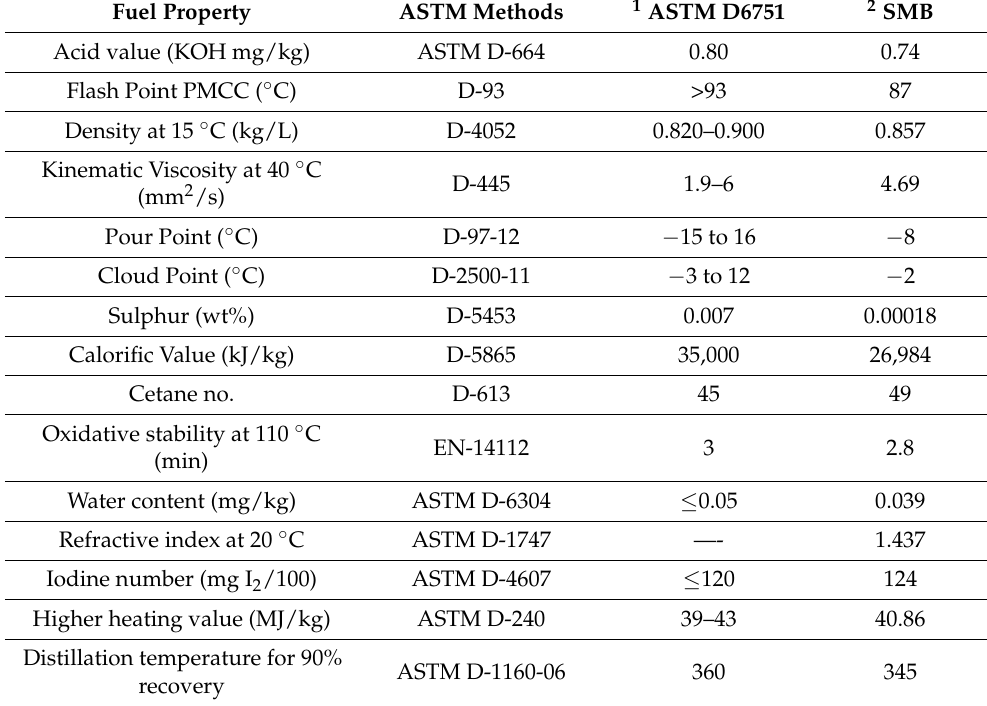
Table 1. Fuel properties of the Silybum marianum biodiesel and ASTM standard method